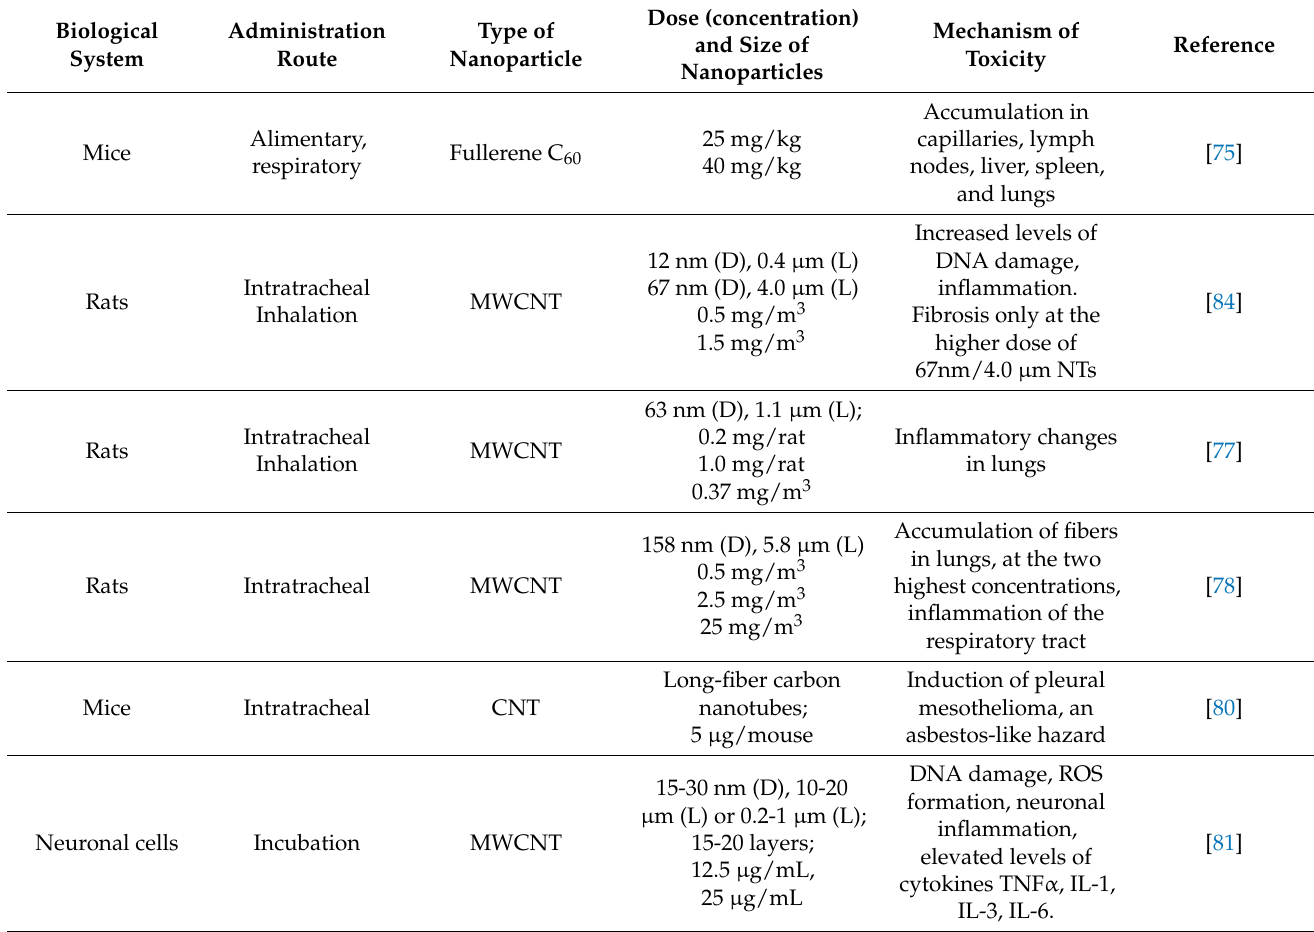
Table 1. Toxicity of carbon nanoparticles on biological systems depending on the dose and size in vitro and in vivo; D—diameter, L—length of